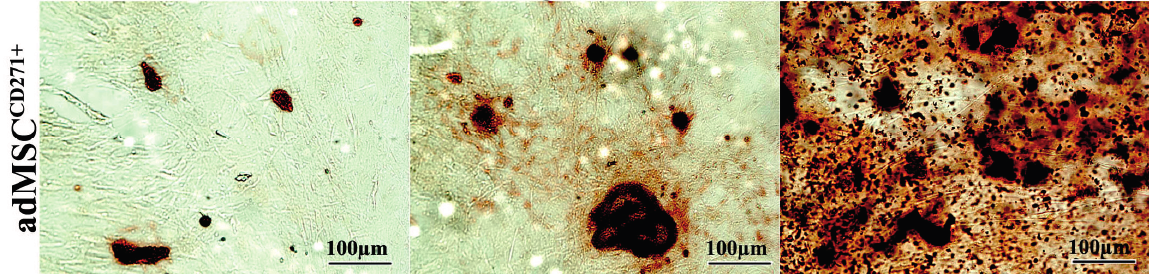
Figure 4. Alizarin Red staining of bmMSC CD271 − , bmMSC CD271+ and adMSC CD271+ after 8, 16 and 24 days of osteogenic induction.